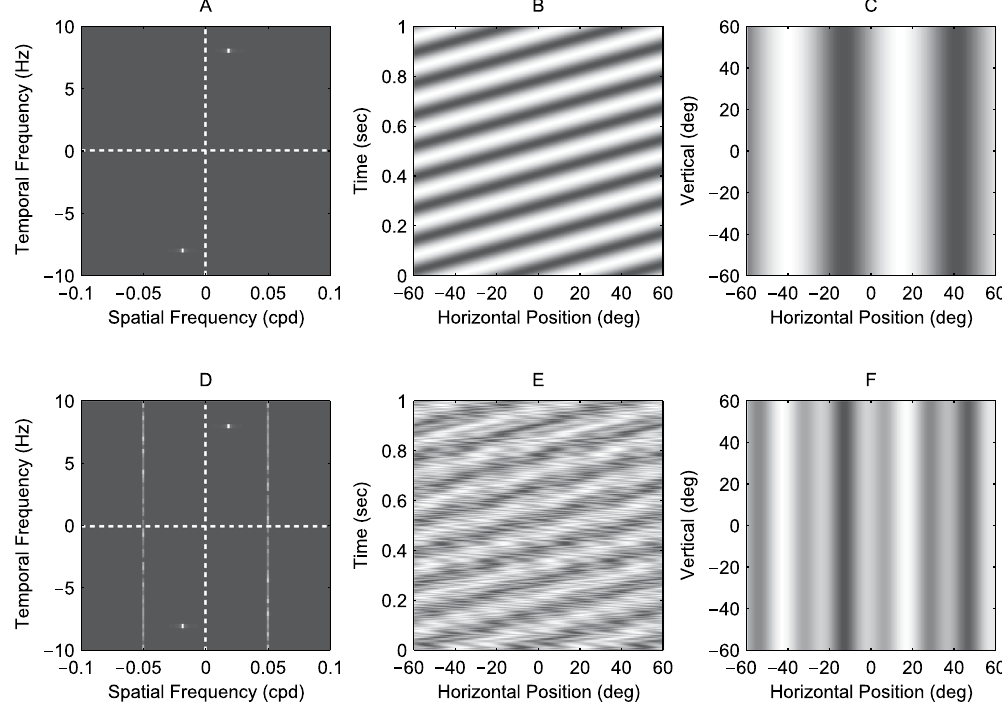
Figure 7. Masked grating visual stimuli used in the experiment. ( A , D ) Spatiotemporal Fourier spectra, ( B , E ) space-time plots and ( C , F ) still frames of the visual stimulus in two conditions of the experiment. Panels (A–C) represent a no-noise condition: the stimulus is a moving grating at 0.0185 cpd and 8 Hz with no added noise. Panels (D–F) represent a masked condition: the stimulus consists of the same signal grating but with non- coherent temporally-broadband noise added at 0.05 cpd. There were in total 44 conditions in the experiment (4 unmasked and 40 masked gratings). Noise was always temporally broadband and its spatial frequency varied across conditions (in the range 0.0012 to 0.5